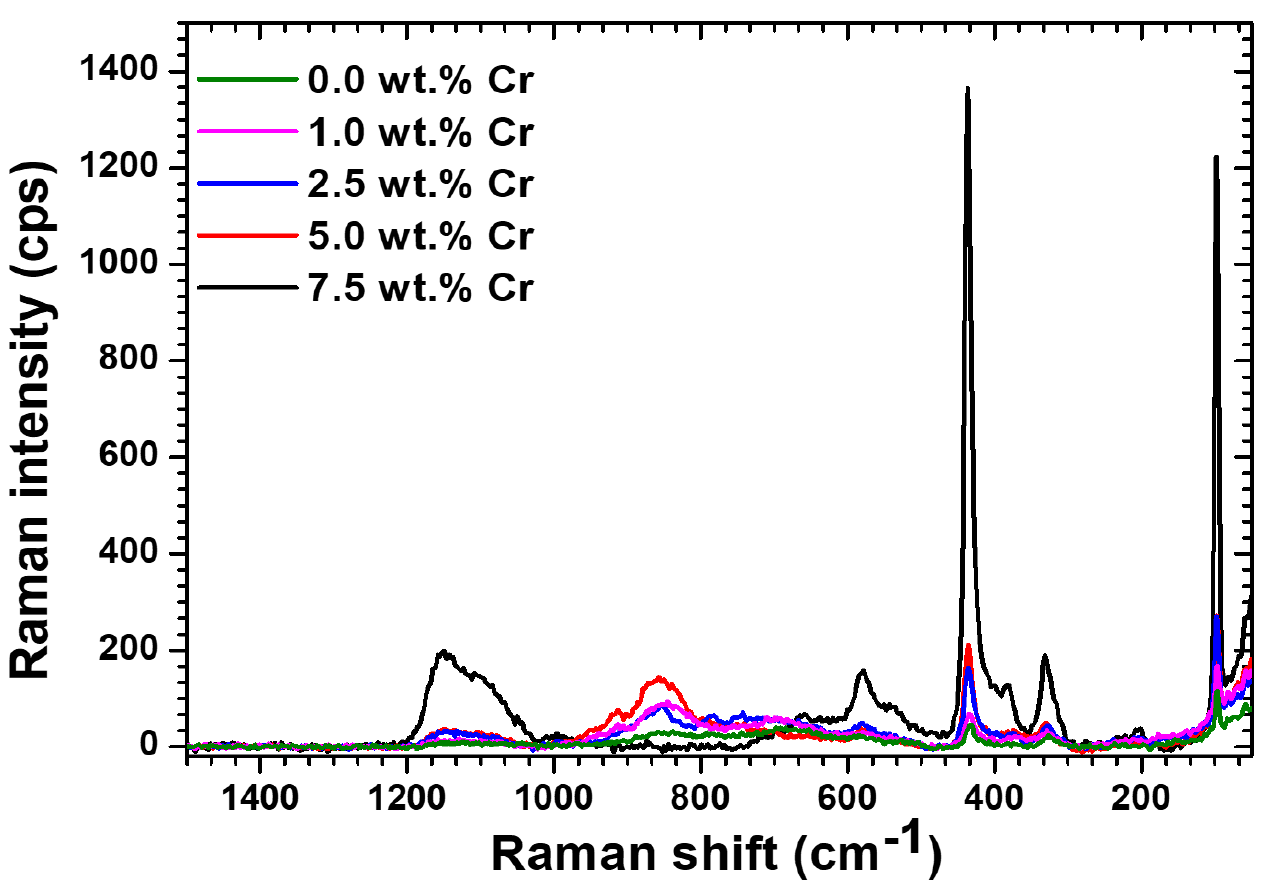
Figure 2. Raman spectra for pure and Cr-doped ZnO NPs.